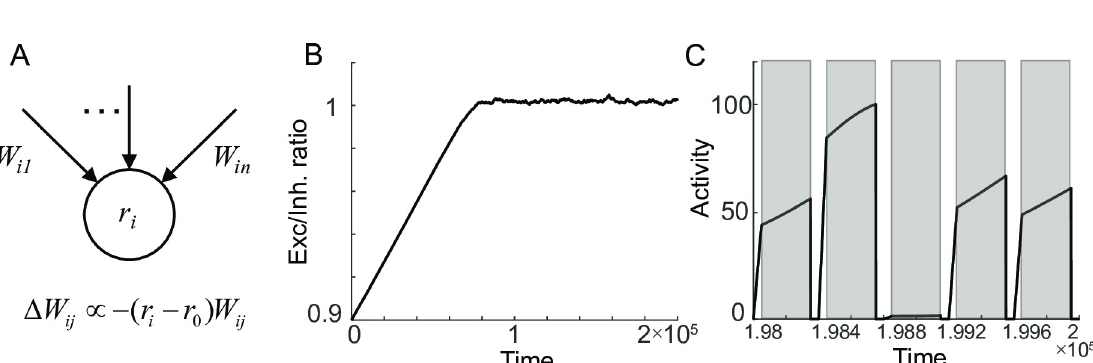
Fig 3. Recovery of rate-coded persistent activity through homeostatic plasticity. A: Schematics of homeostatic plasticity scaling the . B-C: Recovery of E-I balance after perturbations in connectivity strengths of incoming synapses to achieve the target firing rate r 0 strengths (B) and maintenance of persistent activity at the different levels after the recovery